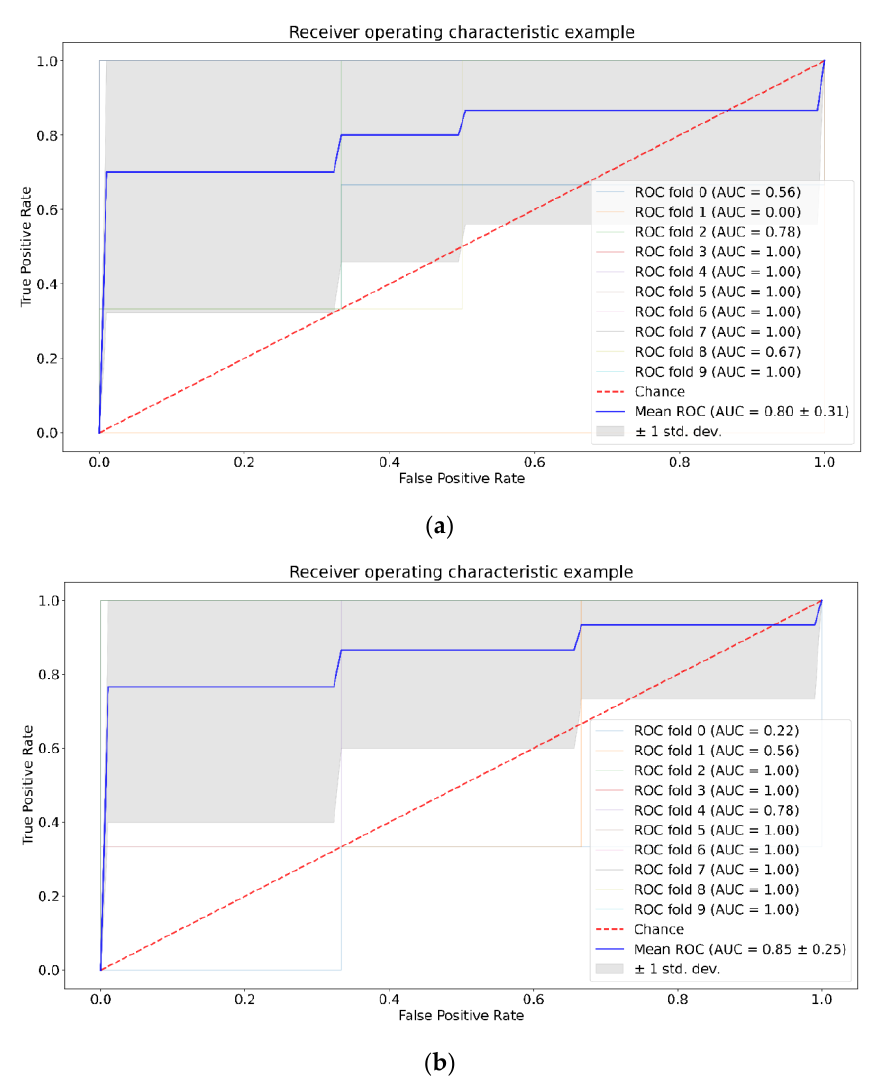
Figure 5. ROC AUC analysis for SVM, third week, no PCA ( a ) and with PCA ( b ).